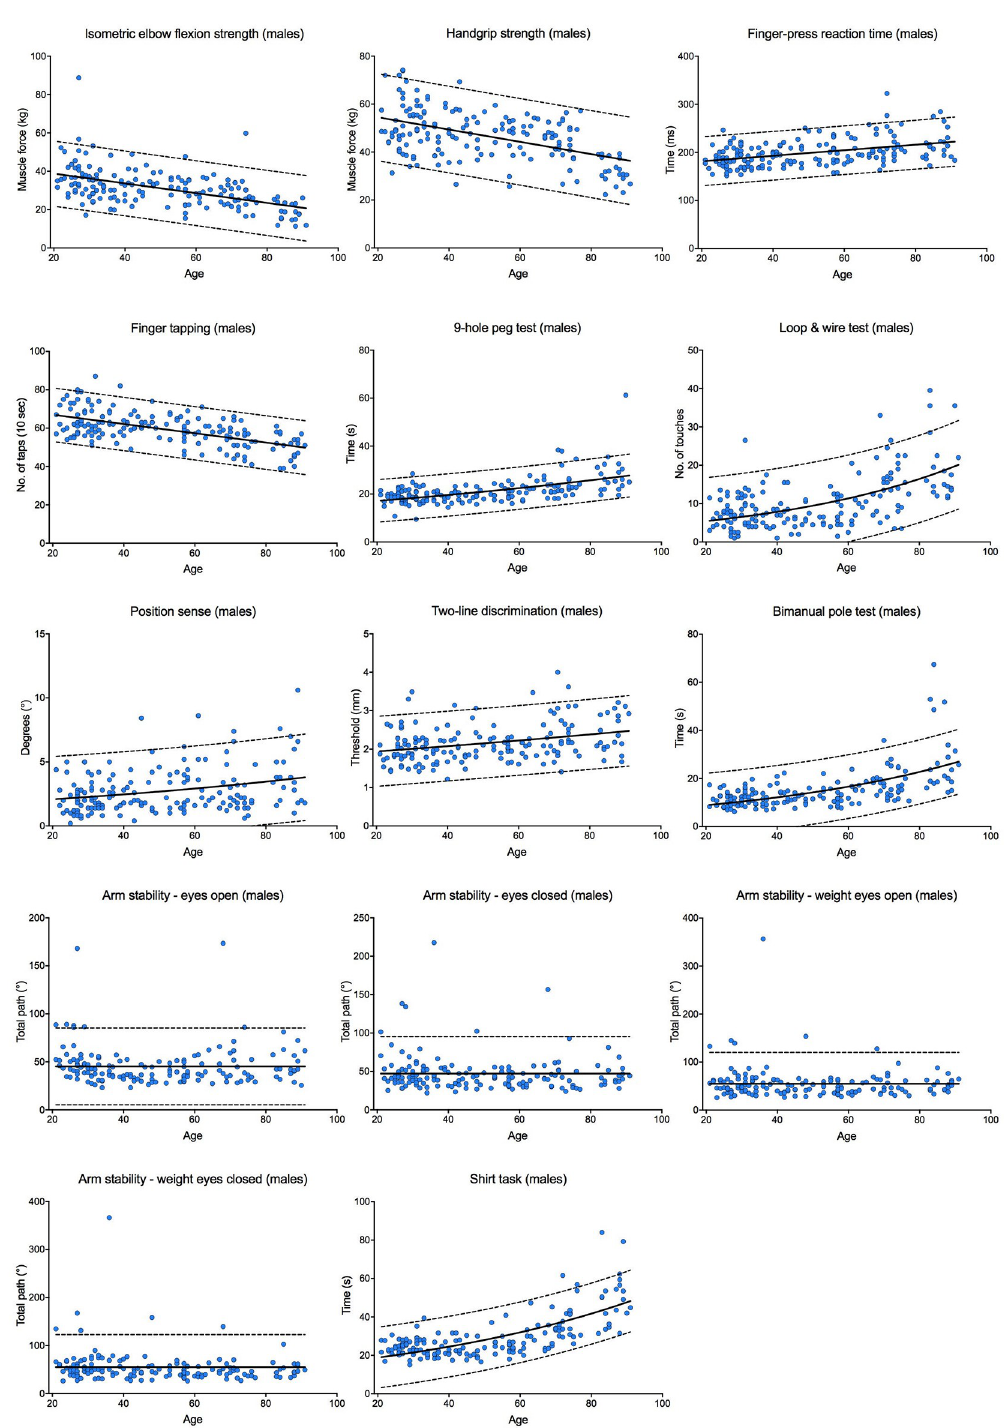
Fig 9. Individual test performance plotted against age in males. Individual participant scores are plotted against age for each of the continuously scored tests. The continuous black line represents the regression line and the broken black lines represent the 95% prediction